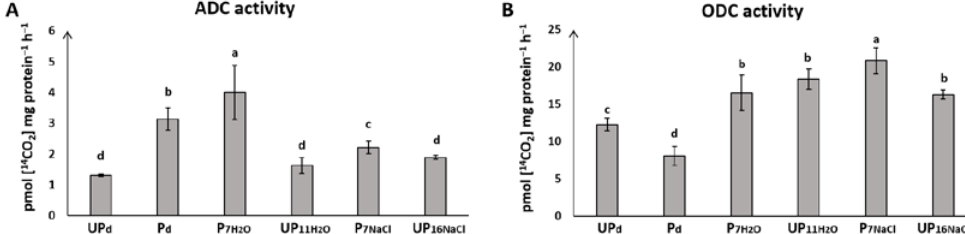
Figure 3. Activity of ( A ) arginine decarboxylase (ADC) and ( B ) ornithine decarboxylase (ODC) in the seeds of Brassica napus before the start of germination (dry unprimed seeds, UP d and primed dried seeds, P d ) as well as during germination (primed seeds germinating for 7 h in water, P 7H 2 O ; unprimed seeds germinating for 11 h in water, UP 11H 2 O; primed seeds germinating for 7 h in NaCl, P 7NaCl ; unprimed seeds germinating for 16 h in NaCl, UP 16NaCl ). The differences were statistically significant, as determined by one-way analysis of variance (ANOVA) and Tukey–Kramer multiple comparison test ( n = 6, p < 0.05). The vertical bars denote SD. The same letters on bars describe not significant differences between means. Figure 4. Concentration of free tyramine in the seeds of Brassica napus before the start of germination (dry unprimed seeds, UP d and primed dried seeds, P d ) as well as during germination (primed seeds germinating for 7 h in water, P 7H 2 O ; unprimed seeds germinating for 11 h in water, UP 11H 2 O ; primed seeds germinating for 7 h in NaCl, P 7NaCl ; unprimed seeds germinating for 16 h in NaCl, UP 16NaCl ). The differences were statis tically significant, as determined by one -way analysis of variance (ANOVA) and Tukey –Kramer multiple comparison test ( n = 6, p < 0.05). The vertical bars denote SD. The same letters on bars describe not significant differences between means.